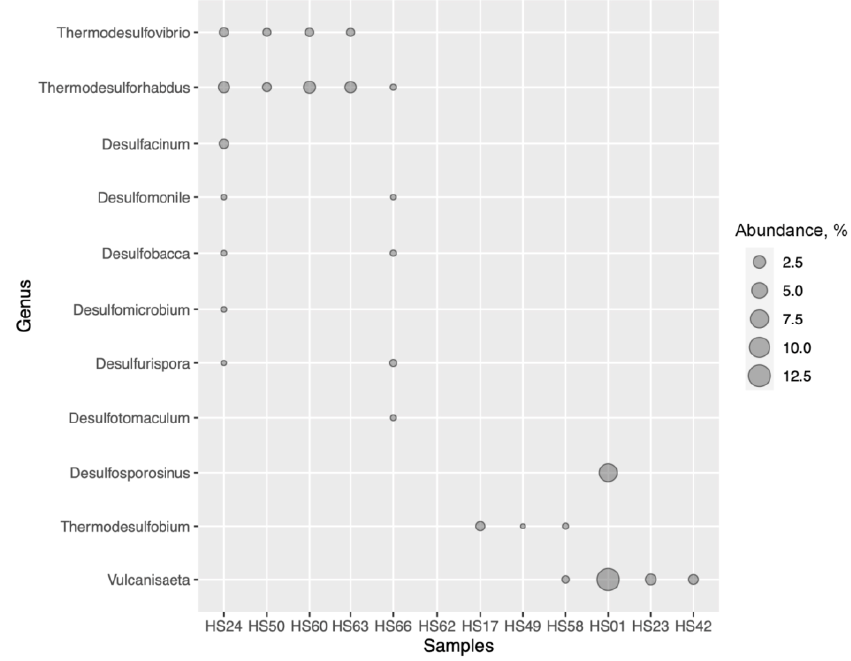
Figure 2. SRP detected by high-throughput sequencing of 16S rRNA gene fragments. Sulfate-reducing representatives of Desulfobacterota , Nitrospirota and Firmicutes were present in 5 out of 12 studied microbial communities (HS24, HS50, HS60, HS63 and HS66), which is in good agreement with the results of dsrB amplicon sequencing. However, we failed to find representatives of the genus Thermodesulfobacterium , whose dsrB sequences were detected by dsrB amplicon sequencing in this group of hot springs. ASVs classified as Thermodesulforhabdus ( Desulfobacterota ) comprised from 0.1 to 2.3% of all sequences in all five communities, while representatives of genus Desulfacinum ( Desulfobacterota ) were present only in sample HS24 (1.0%). We also found representatives of mesophilic sulfate- reducing Desulfobacterota ( Desulfomicrobium , Desulfobacca and Desulfomonile ) in microbial communities HS24 and HS66, but their share was negligible (<0.1%). The representatives of the genus Thermodesulfovibrio ( Nitrospirota ) were present in four microbial communities (HS24, HS50, HS60 and HS63), accompanying Thermodesulforhabdus . Their share varied from 0.5 to 0.9% of all sequencing of 16S rRNA gene fragments. Thermophilic sulfate- reducing representatives of the phylum Firmicutes were found only in spring HS66, where ASVs classified as Desulfurispora and Desulfotamaculum comprised 0.3 and 0.1% of all se- quences, respectively. Representatives of genus Thermodesulofobium were present in two microbial commu- nities — HS17 and HS58, where their ASVs comprised 0.9 and 0.1% of all sequences respec- tively. Other representatives of sulfate-reducing bacteria could not be identified in these samples, neither by 16S rRNA, nor by dsrB profiling. Recently the ability to dissimilatory sulfate reduction was proven for “ Candidatus Vulcanisaeta moutnovskia” [5]. Representatives of genus Vulcanisaeta were present in four microbial communities (HS01, HS23, HS42 and HS58), where their ASVs comprised from 0.4 to 12.9% of all sequences. The highest share of Vulcanisaeta was detected in microbial community HS01 with temperature 90 °C and pH 3.5. The share of Vulcanisaeta in other hot springs was significantly lower, possibly due to temperature decrease and pH in- crease. It is important to note that representatives of Vulcanisaeta were not detected by dsrB amplicon sequencing because we used primer set specific for reductive bacterial-type dsrB , while representatives of Crenarchaeota phylum contain reductive archaeal-type dsrB .